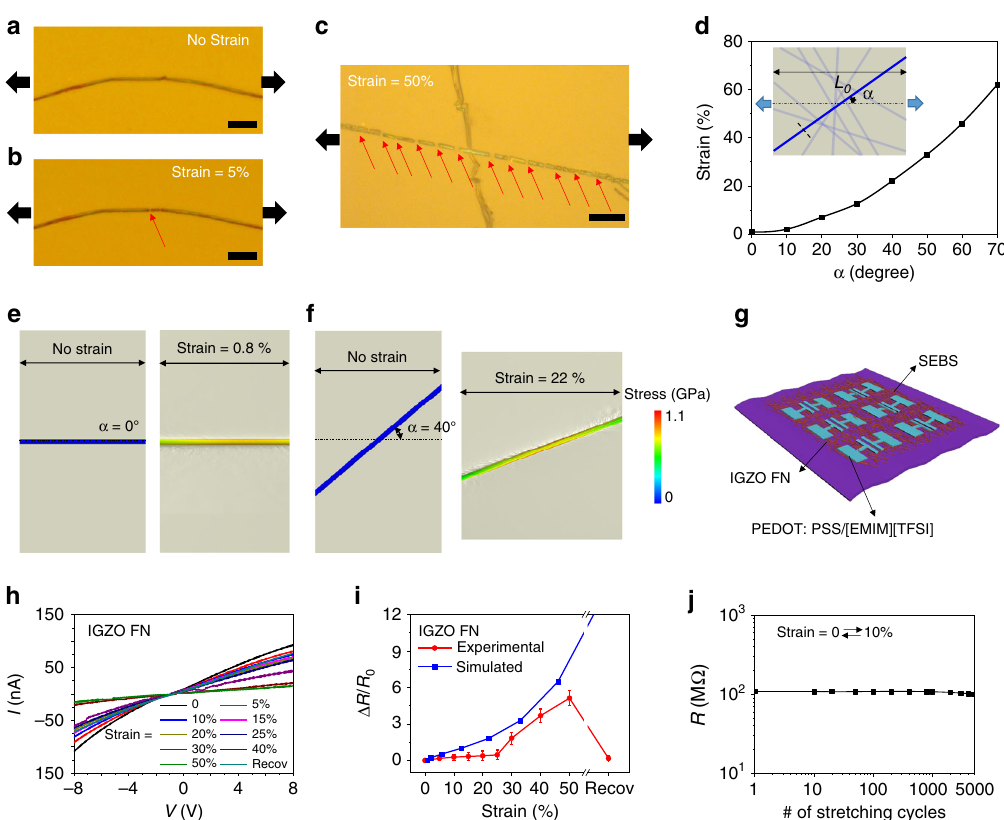
Fig. 3 Experimental and theoretical results for IGZO single fi ber and FN under strain. a , b Optical images of an IGZO single fi ber on SEBS with/without a 5% tensional strain; stretching directions are parallel to the fi ber long axes and are indicated by black arrows. Scale bar = 10 µ m. c Optical image of two crossed IGZO fi bers on a SEBS substrate under a 50% strain. Scale bar = 10 µ m. d Simulated strain needed to achieve 1.1 GPa stress on single IGZO fi ber when fi ber has different angles ( α ) with respect to the stretching direction. Simulated stress distribution on a single fi ber when reaching fracture, i.e., maximum stress in fi ber to reach fracture at 1.1 GPa. Single fi ber has a e α = 0° and f α = 40° angle with respect to tensile direction. g Schematic of stretchable IGZO FN resistors. h I – V curves of IGZO FN devices under different tensile strains. i Experimentally derived resistance change (red) of IGZO FN devices under different strains and simulated resistance change (blue) of a randomly oriented IGZO FN under different strains. j Resistance of an IGZO FN device after 5000 0 – 10% strain